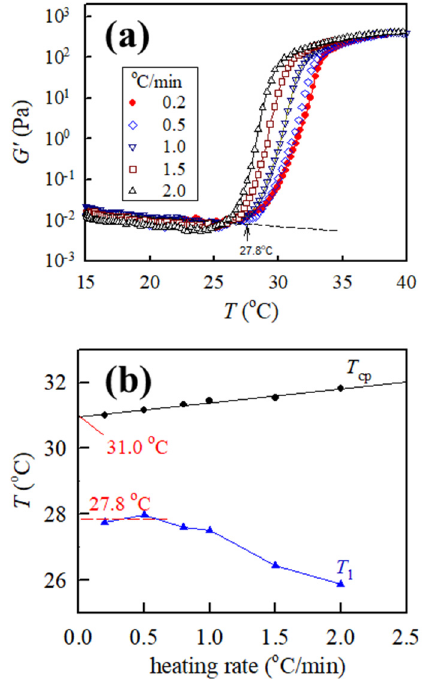
Figure 6. ( a ) Effects of heating rates on the dynamic storage modulus G ′ of the 5.5 wt% a-PNIPAM aqueous solutions at an applied frequency of 5 rad/s, and ( b ) heating rate effects on the obtained transition temperatures ( T 1 and T cp ) of the 5.5 wt% solution.